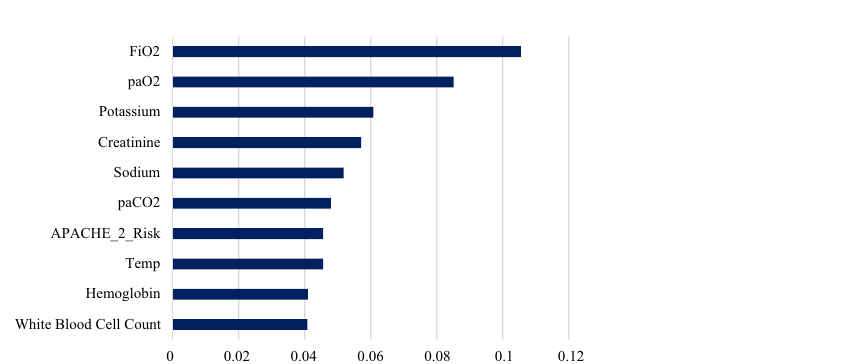
Figure 4. Predictor importance chart for Artificial Neural Networks partial pressure of carbon dioxide